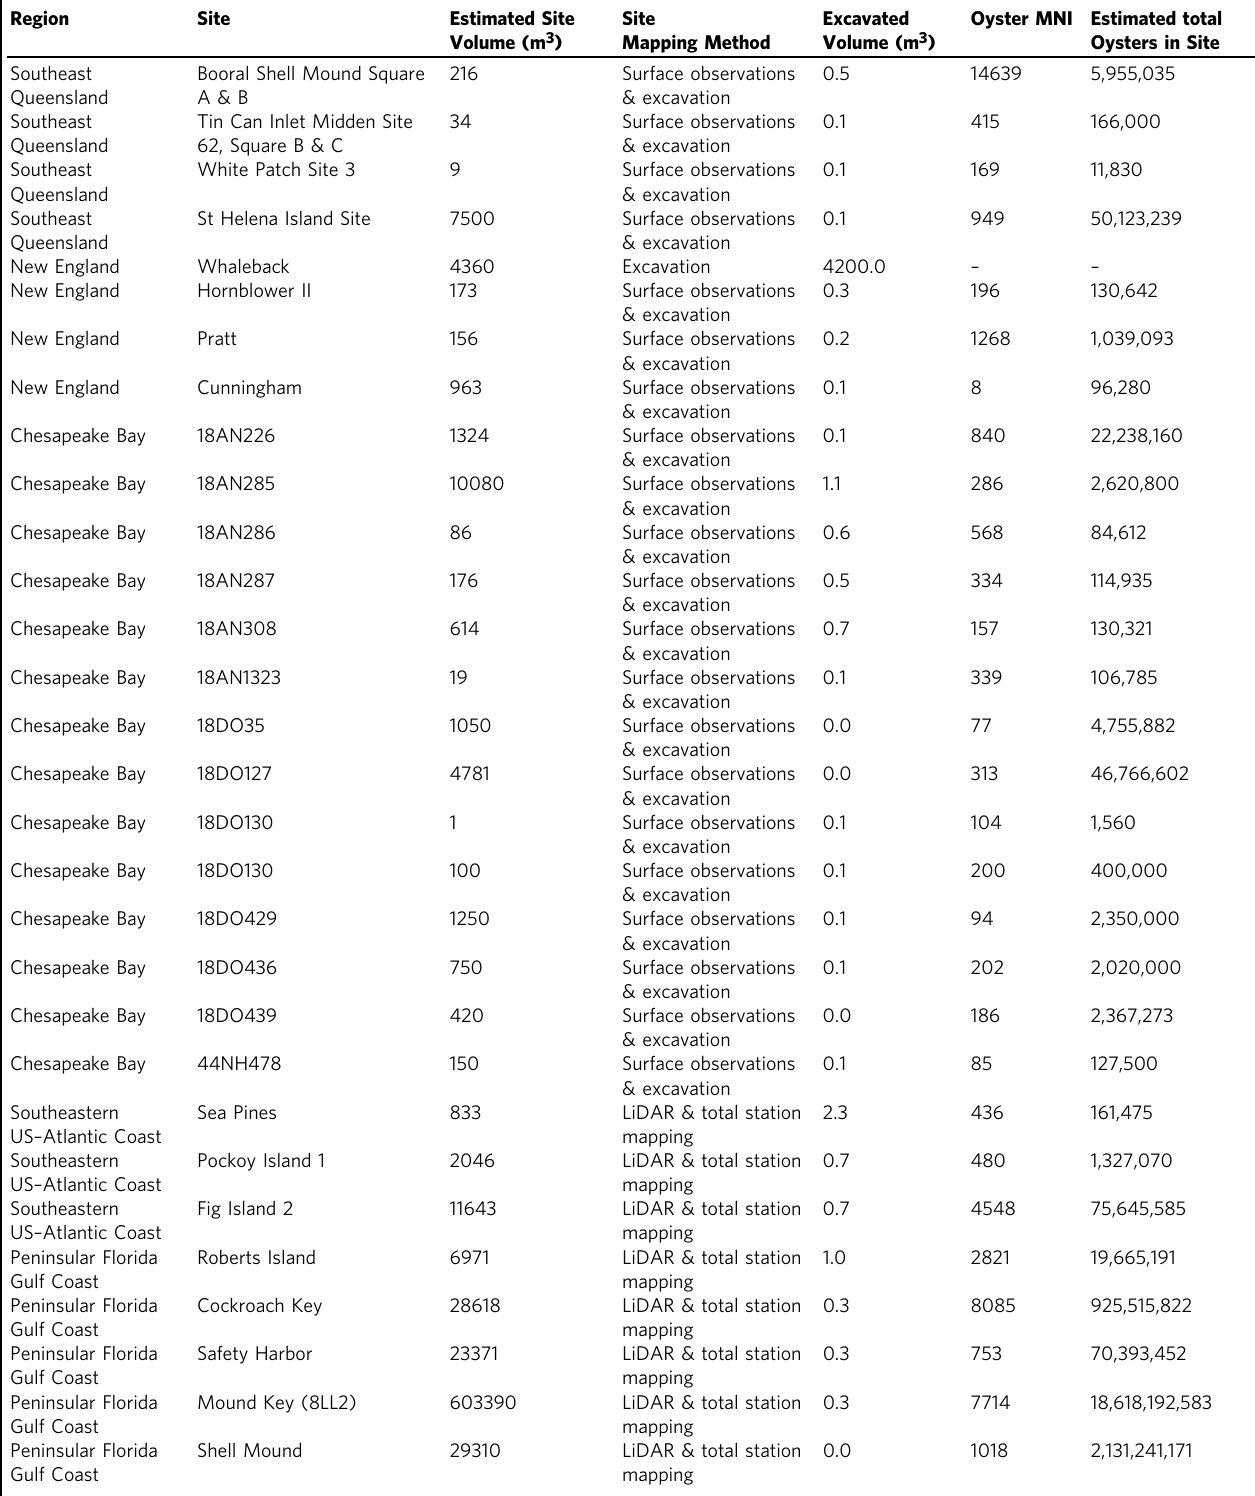
Table 1 Estimated absolute abundance of